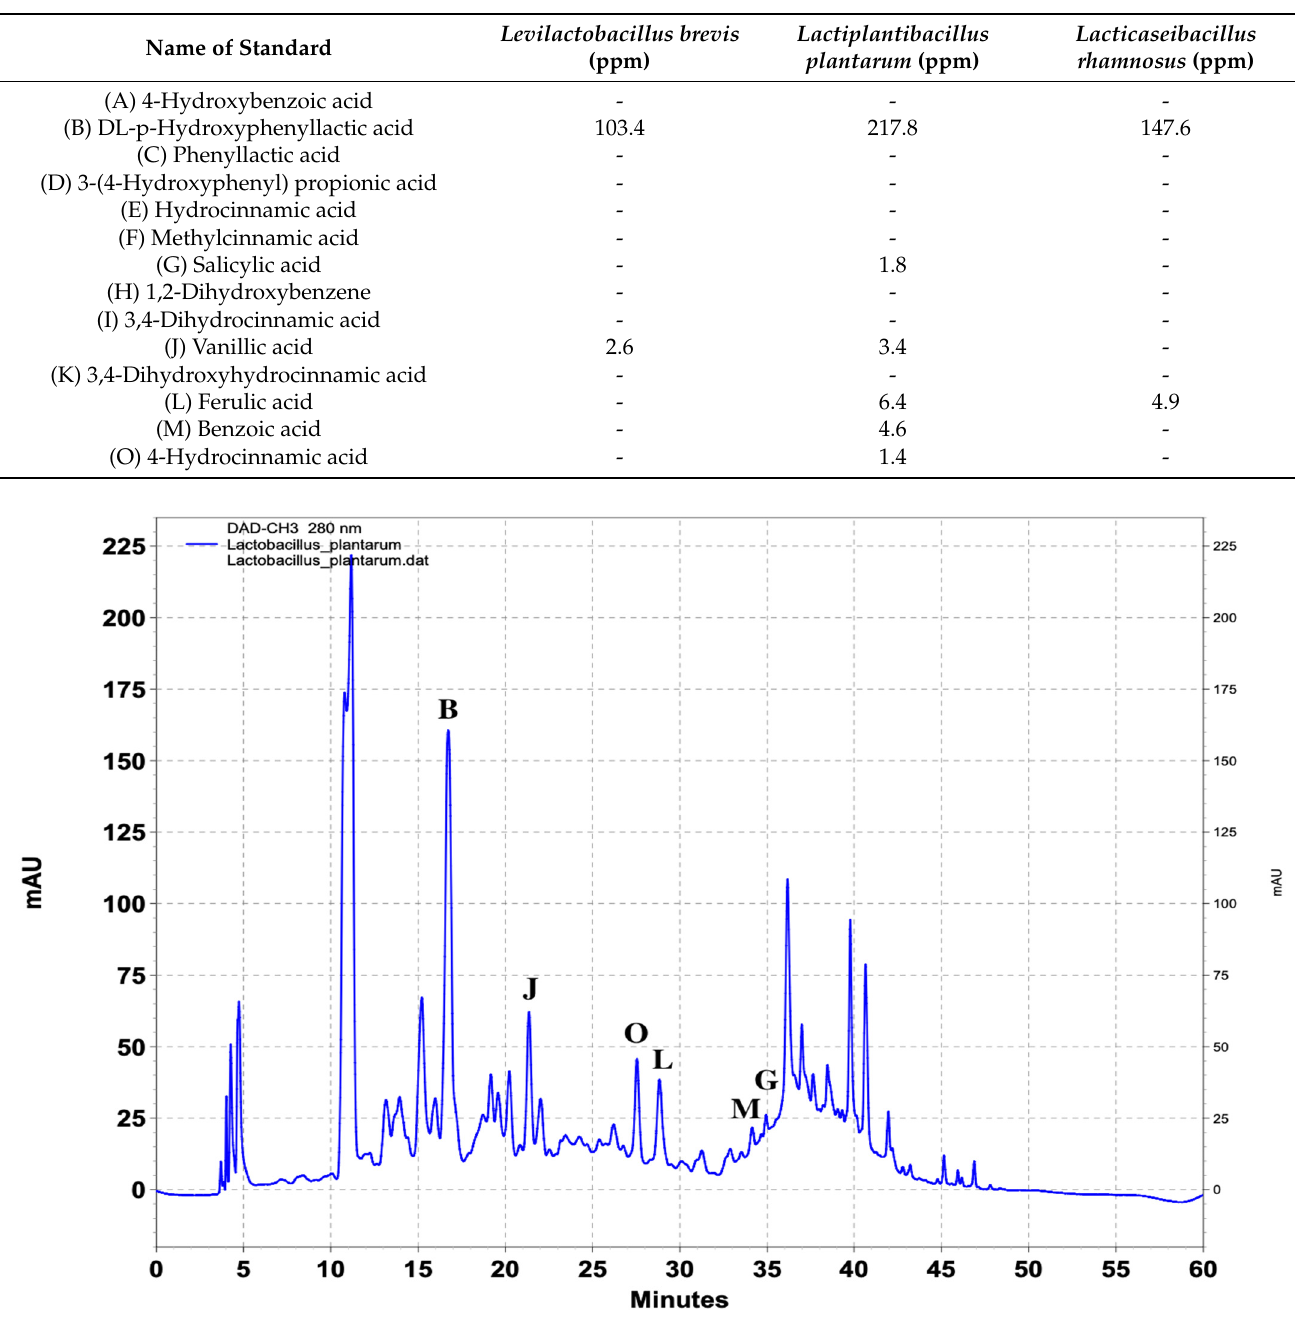
Table 2. Concentration (in ppm) of the 14 tested compounds determined in Levilactobacillus brevis ,